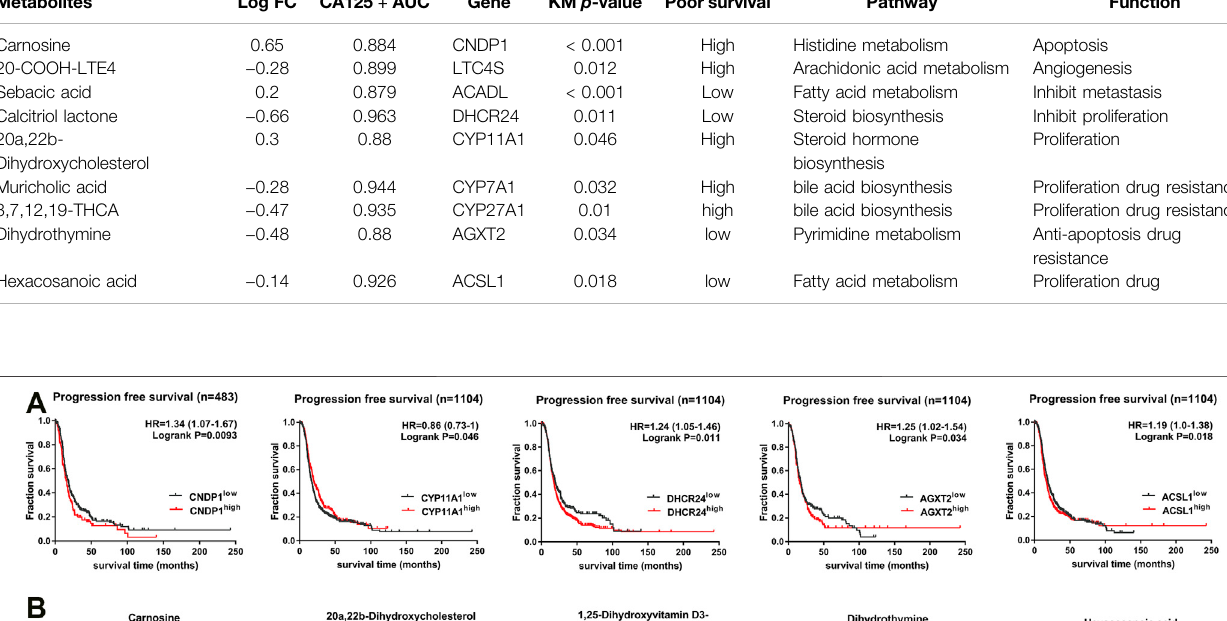
TABLE 1 | Biological function of potential biomarkers and related enzyme genes in ovarian cancer. Metabolites